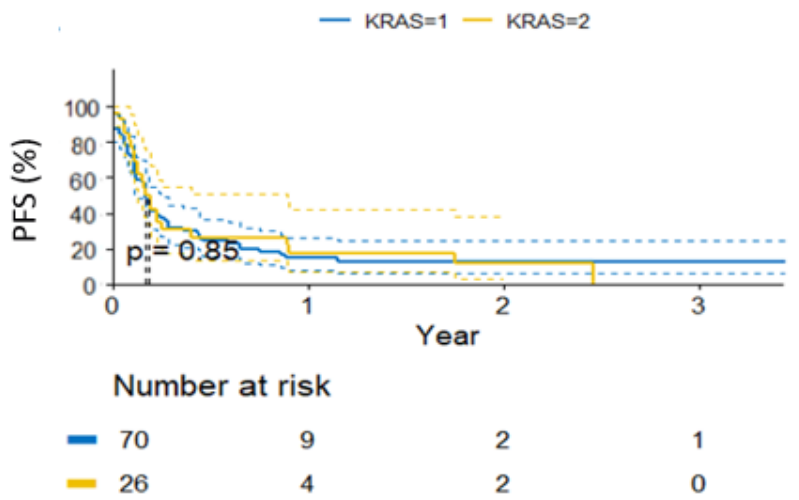
Figure 2. Probability of progression-free survival in the entire population under analysis.